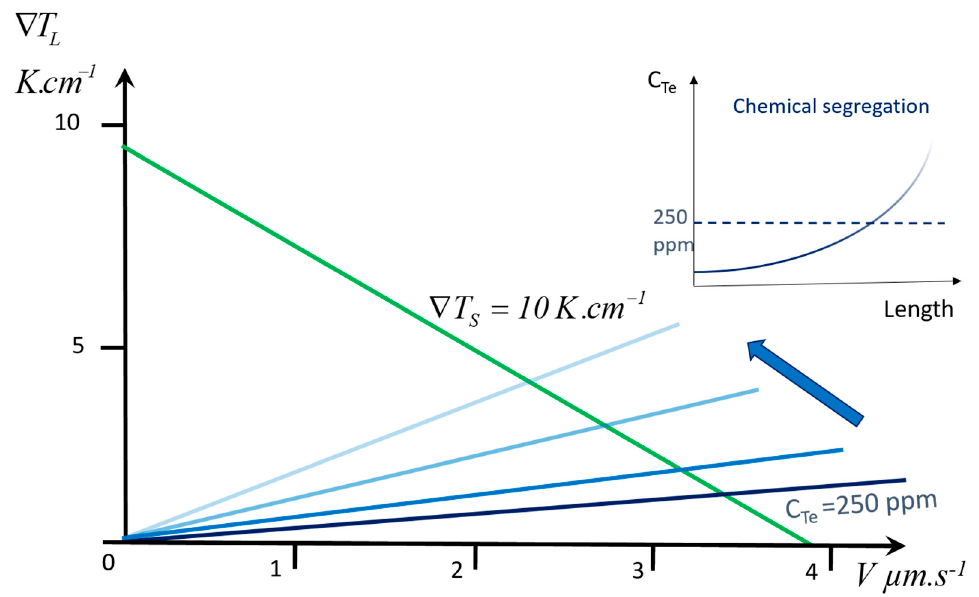
Figure 4. Diagram modified in order to take into account the chemical segregation of tellurium. Its increase with length changes the interface stability criterion, following the